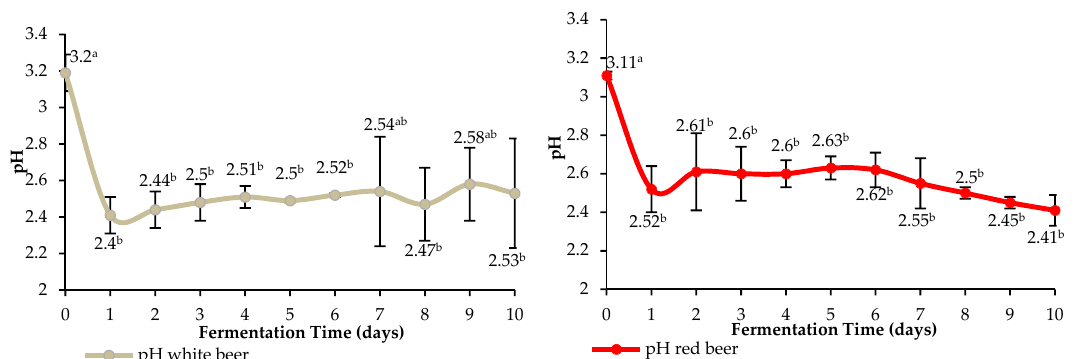
Figure 1. Evolution of pH during fermentation of the indigenous sorghum beers. Mean values ( n = 3 repetitions) preceded by at least one common letter (a, b) were not significantly different ( p < 0.05). Bars represent standard deviations.